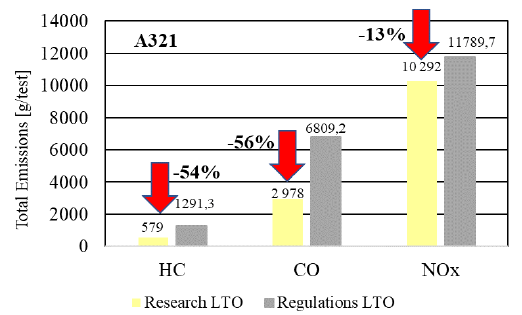
Fig. 16. Total emission of toxic exhaust fumes for adopted and regulations LTO for